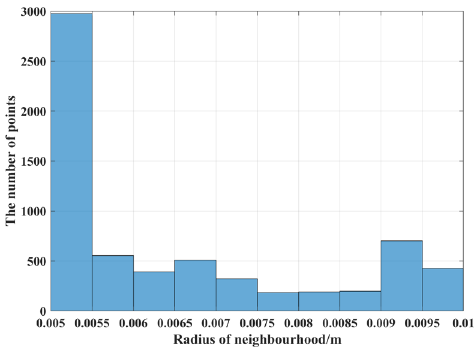
Figure 17. Shelf scene target pallet point cloud adaptive optimal neighborhood radius. The AGWF feature descriptors of the source point cloud and the target pallet point cloud are calculated based on the minimum neighborhood radius, and the AGWF feature of a point is shown in Figure 18.